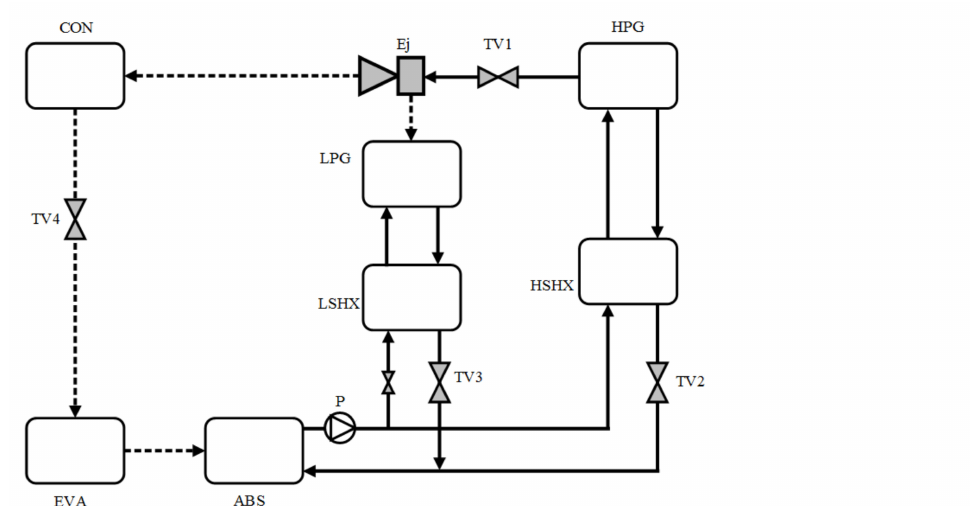
Figure 5. HEARS driven by multi-heat source